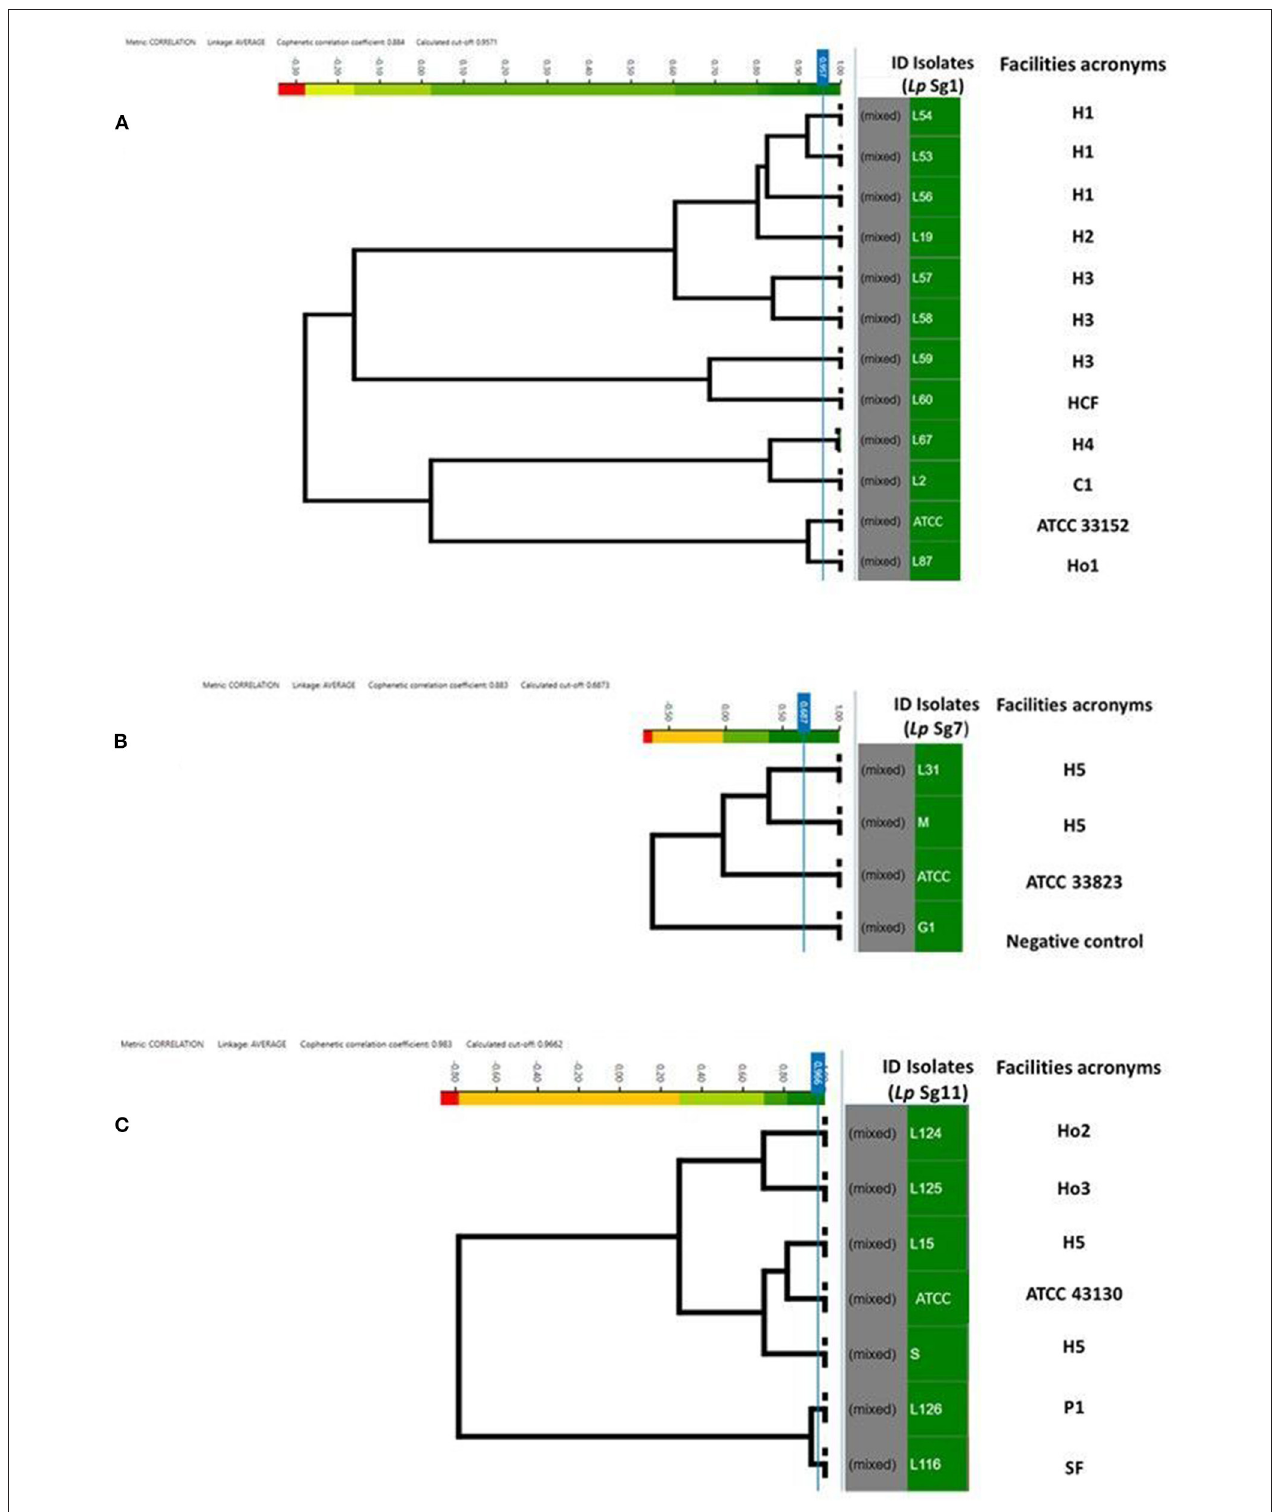
FIGURE 4 | Clustering of IR Biotyper® by HCA, developed for dendrograms: Lp Sg1 (A) , Lp Sg7 (B) , Lp Sg11 (C) isolates. In the gray column the term “mixed” is referred to the merging of spectra obtained for each isolate. In the green column the isolates ID. The NEGATIVE control, was represented by Lp Sg4 isolates (B) . The cut-off value was automatically calculated by instrument software. The “Facility acronyms” used as follows: H, hospital; HCF, health care facilities; C, company; SF, Spa facility; Ho, hotel; P, private homes.